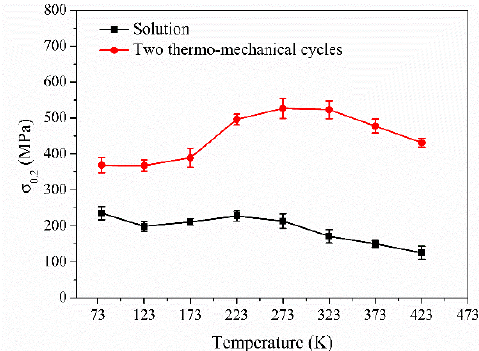
Figure 8. The 0.2% proof stress σ 0.2 as a function of temperatures for solution-treated specimens and the ones subjected to two thermomechanical cycles.